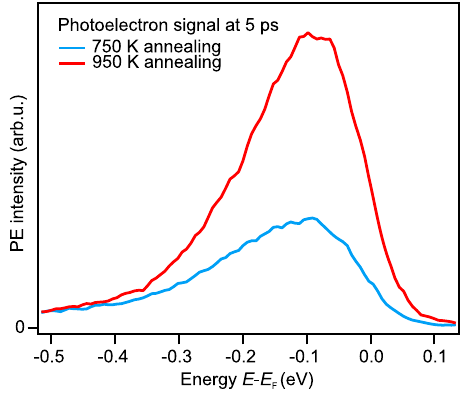
Fig. 4 Sensitivity of the photoresponse to the surface conditions. PE spectra recorded with h ν probe = 6.3 eV and h ν pump = 3.4 eV ( fl uence 140 μ J/cm 2 ) at a pump-probe delay of 5 ps using two different annealing temperatures during the sample preparation (cf. methods and see text). The same fl uence of pump as well as probe laser pulses is used for both shown spectra, hence the absolute PE intensity can be compared. After annealing at 750K (blue), the photoelectron intensity of the pump- induced metal phase is by a factor of 2 – 3 smaller than after annealing at 950 K (red).